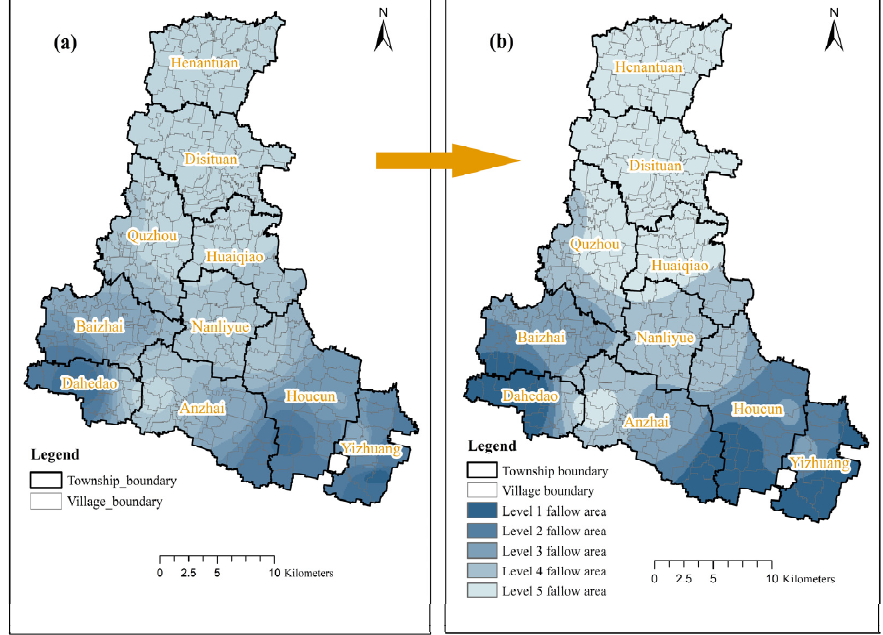
Figure 4. Classification of the urgency situation ( a ) and urgency level ( b ) of cropland fallow in Quzhou County in 2018.